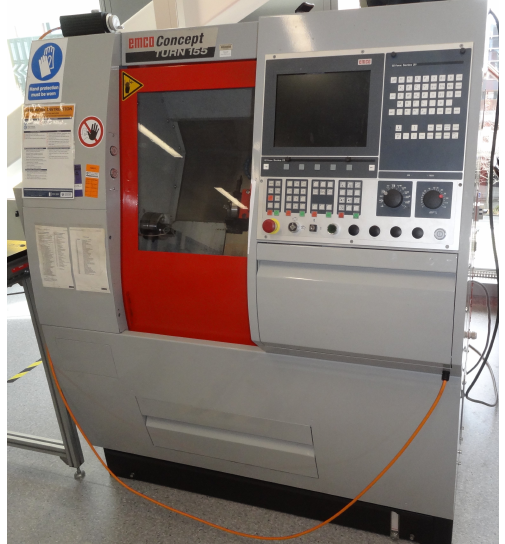
Figure 3. EMCO Concept Turn 155.